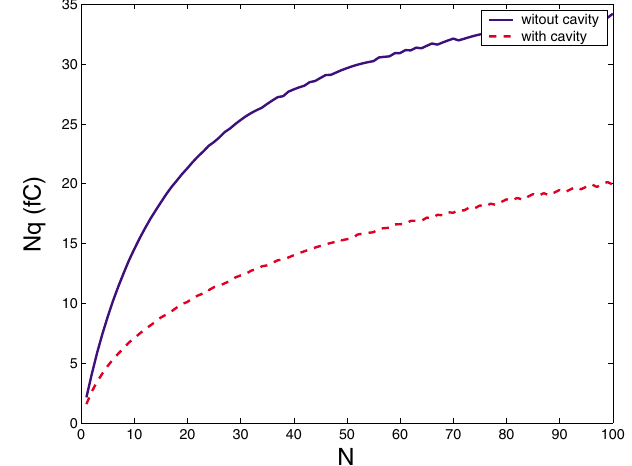
FIG. 6. (Color) The total charge versus number of bunches for (cid:21) (cid:1) 0 : 05 . The average unloaded gradient is 160 MV = m